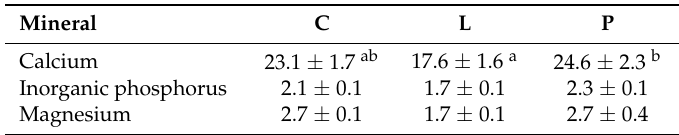
Table 8. Concentrations of calcium, inorganic phosphorus and magnesium (mg/dL) in plasma of laying hens ( n =